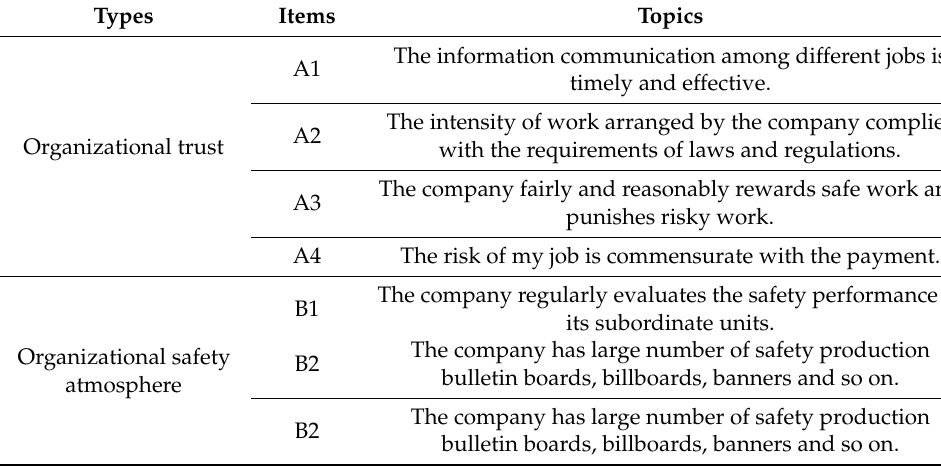
Table A1. Items of formal questionnaire for influencing